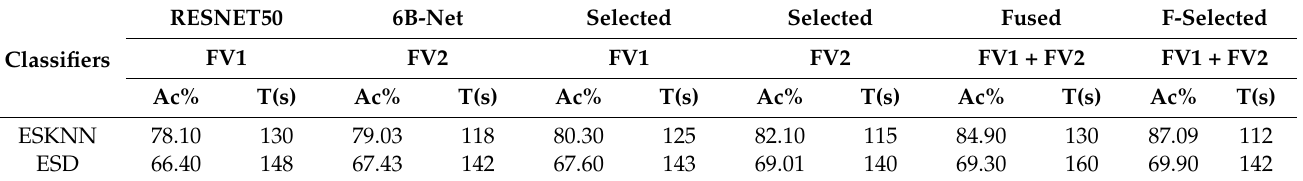
Table 3. Results using proposed feature fusion and selection-based method on BreaKHis dataset with eight classes and three-fold validation, where Ac% represents the accuracy in percent, and T(S) represents the training time in